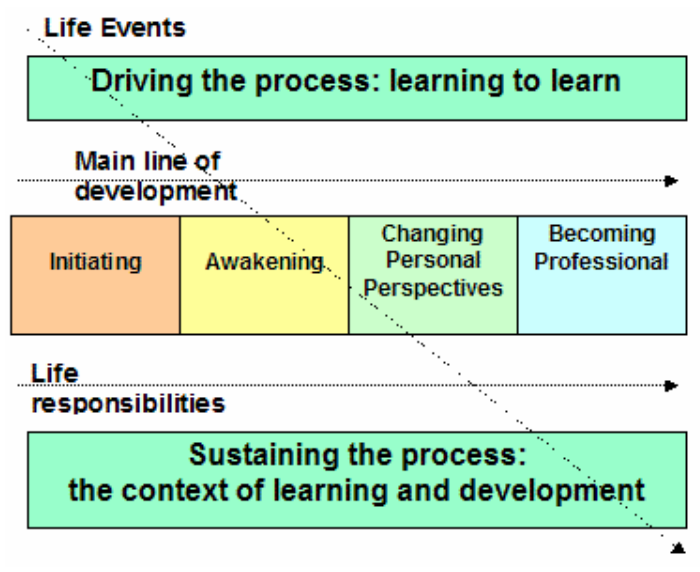
Figure 1 . The Process of